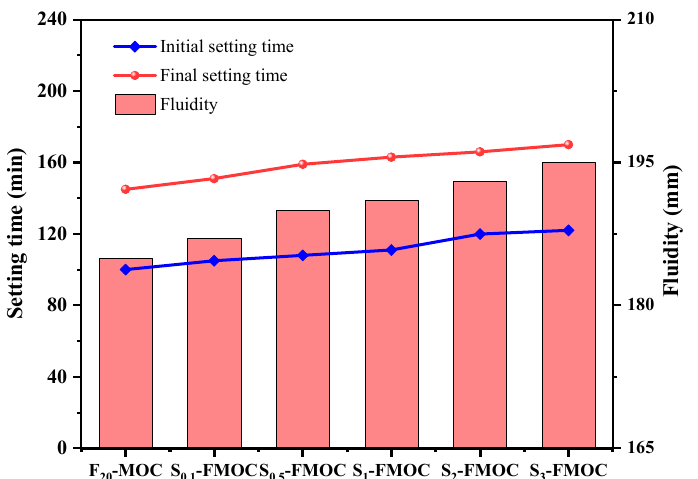
Figure 6. Setting time and fluidity of compound material–magnesium oxychloride cement composite ternary system.